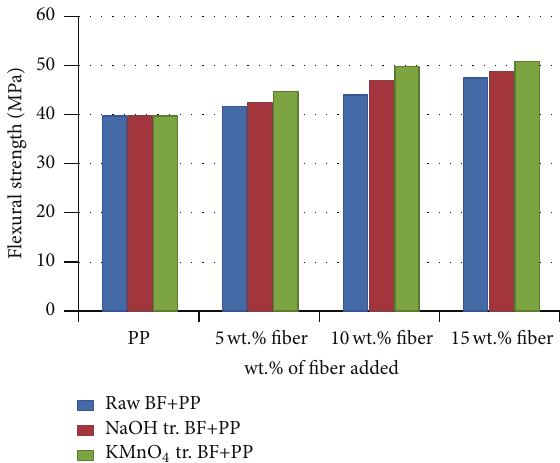
Figure 6: Comparison of flexural strength of different BBF/PP